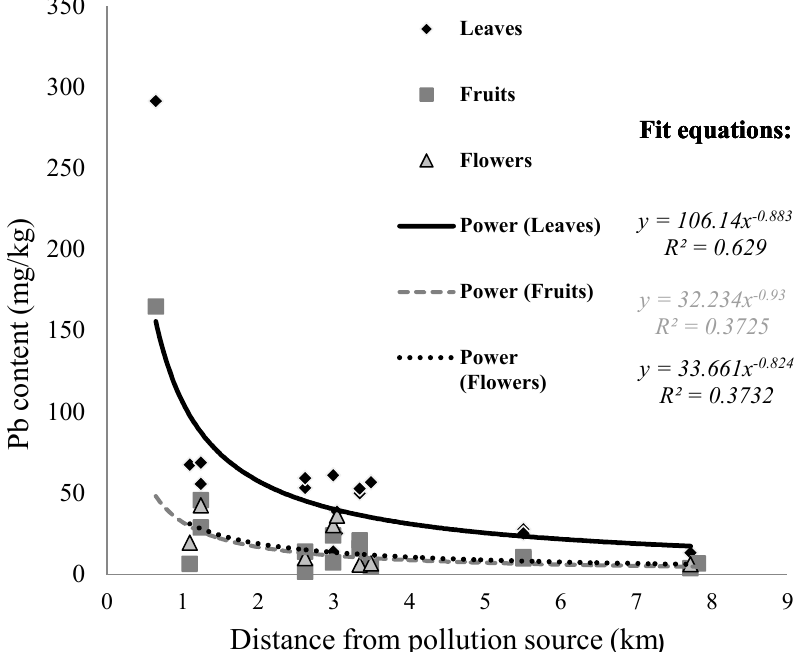
Figure 3. The variation of lead content in relation to the distance from the main source of pollution (control plot is excluded).